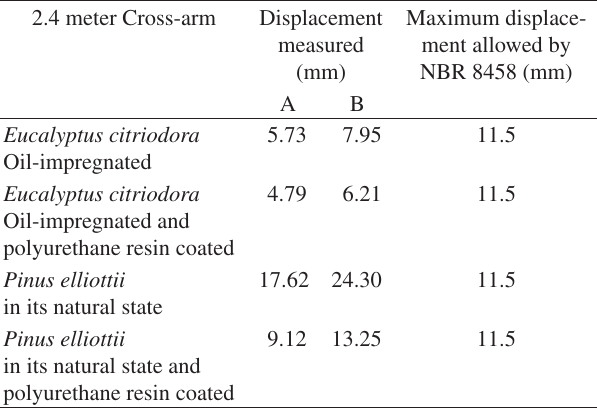
Table 10. Cross-arm bending strength.